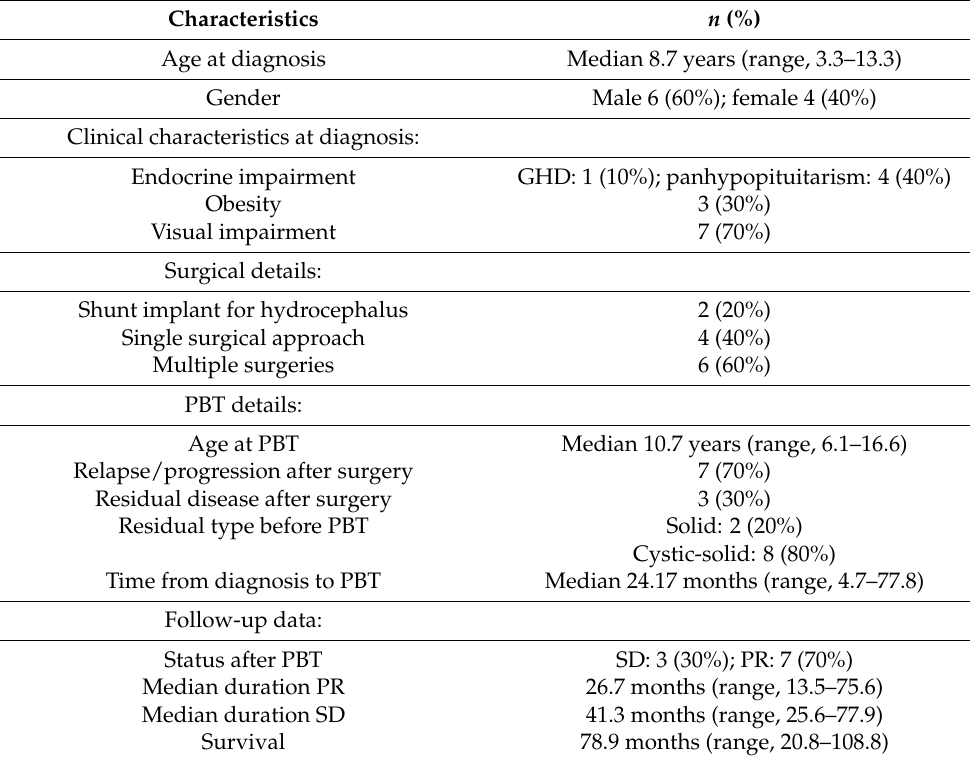
Table 1. Population characteristics, treatment, and follow-up.